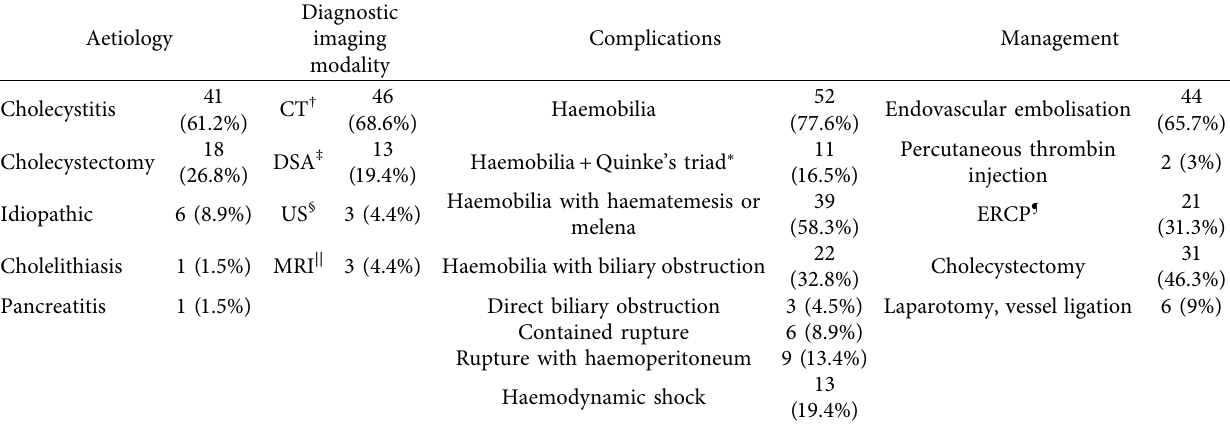
Table 1: A summary of the aetiologies, diagnostic imaging modalities, presentations, and management of CAP.